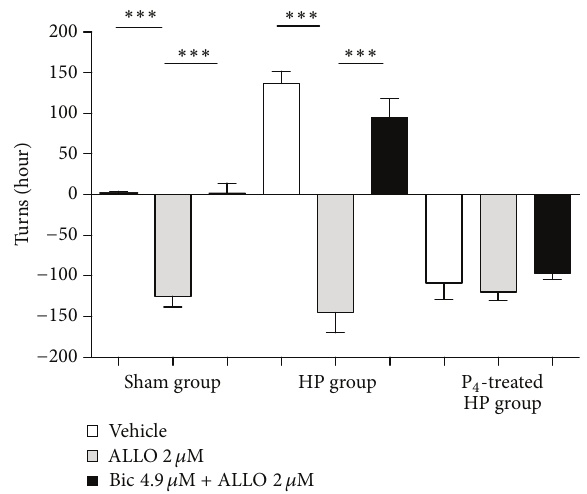
Figure 6: Effect of intraventricular vehicle, ALLO [2 𝜇 M], and bicuculline [4.9 𝜇 M] + ALLO on turning behavior induced by apomorphine at eight weeks after 6-OHDA lesion. Results are expressed as turns/hour; ∗∗∗ 𝑃 < 0.001 (two-way ANOVA). ALLO: allopregnanolone, Bic: bicuculline, HP group: hemiparkinsonian group, and P 4 -treated HP group: progesterone-treated hemiparkin- sonian